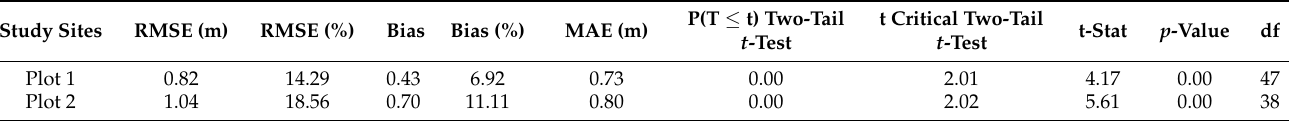
Table 8. Statistical summary of crown diameter estimates for Plots 1 and 2.